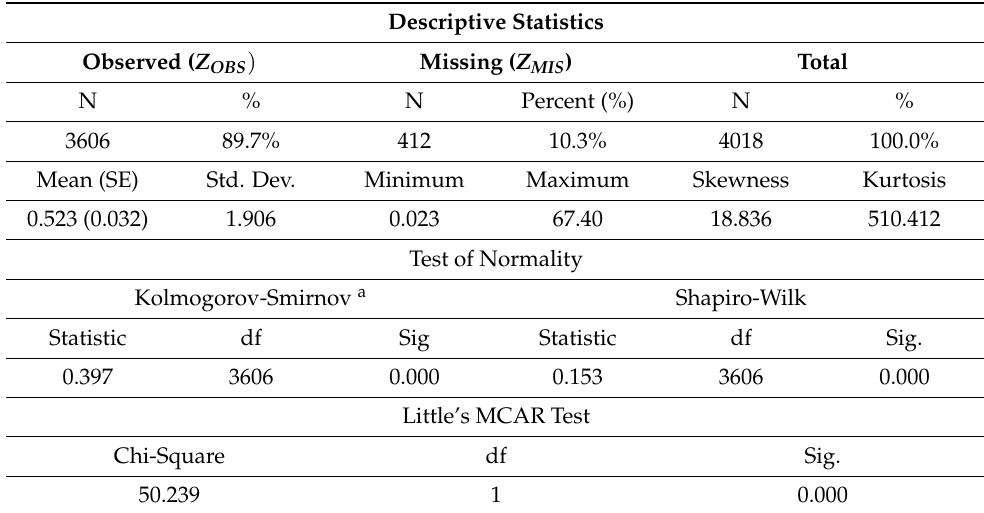
Figure 3. The results of the plot of the raw Zhidan streamflow data series based on the exploratory data analysis (EDA). The results of the descriptive statistics, normality and MCAR test results of Zhidan catchment data are further displayed in Table 3 and Figure S1. Table 3. Descriptive statistics, Normality and MCAR test results of Zhidan catchment data.